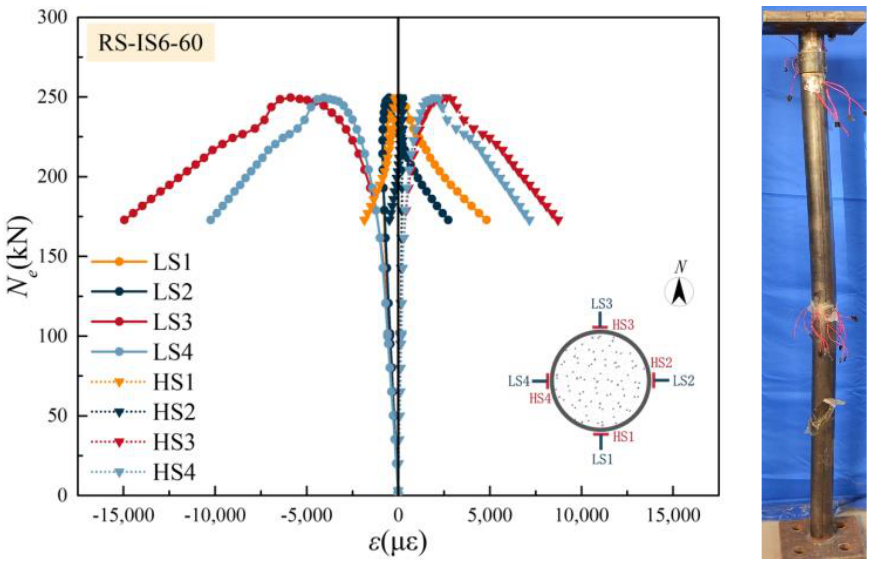
Figure 13. Relationship of N e to longitudinal and hoop strain (RS − IS6 − 60).